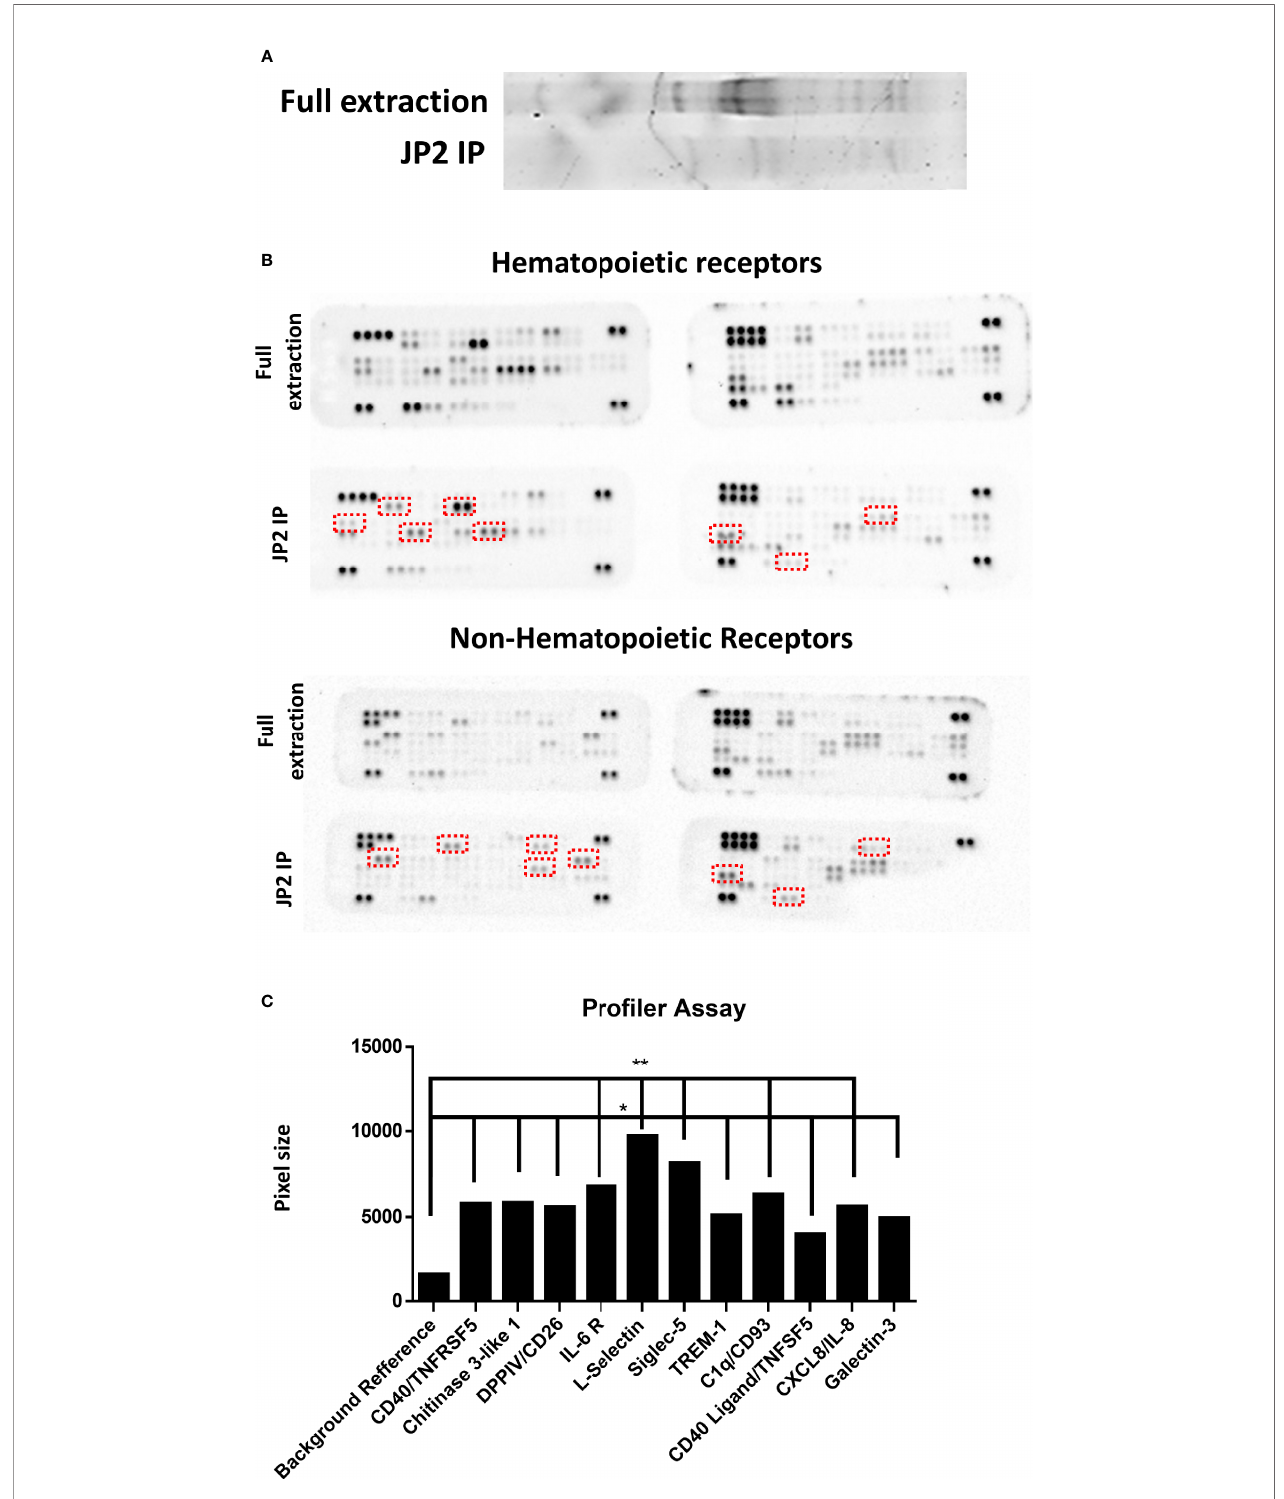
FIGURE 5 | Pro fi ler Quanti fi cation. Wide-range receptors analysis. Proteins adhering to JP2 were isolated with an immunoprecipitation (IP) assay and analyzed with receptor array assays. (A) Gel separation of proteins of the full extract from healthy neutrophils and after JP2 IP. (B) Image of array membranes (hematopoietic and non-hematopoietic receptors) following analysis. The red squares mark signi fi cant dots that show a change between groups. (C) Dot size quanti fi cation (in arbitrary values) of receptors showing enrichment compared with the total protein level as reference point. (*p< 0.05,